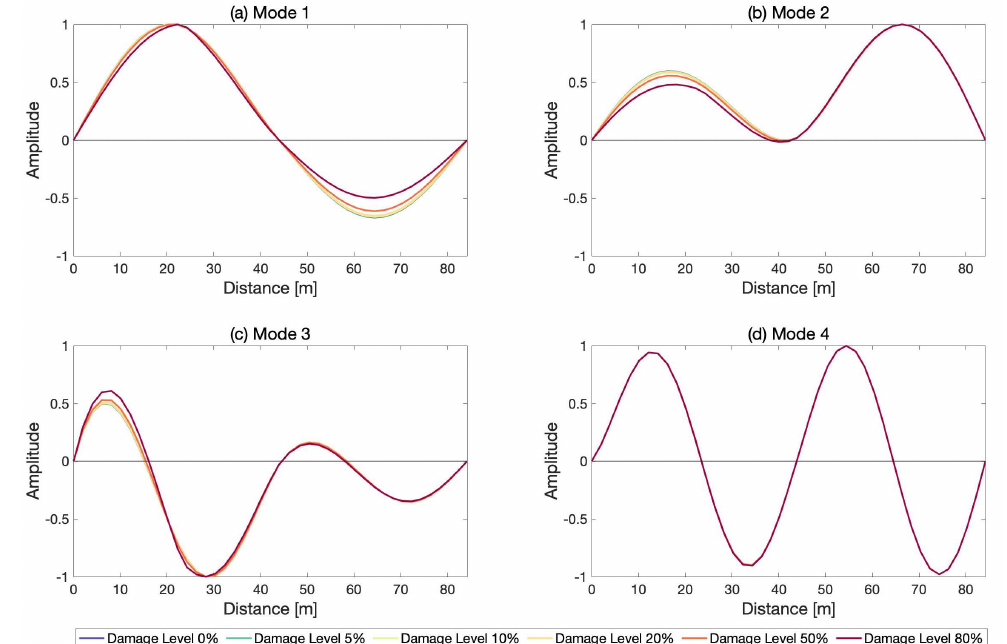
Figure 4. Mode shapes of the first four modes of the undamaged bridge and the bridge damaged at the middle of the first